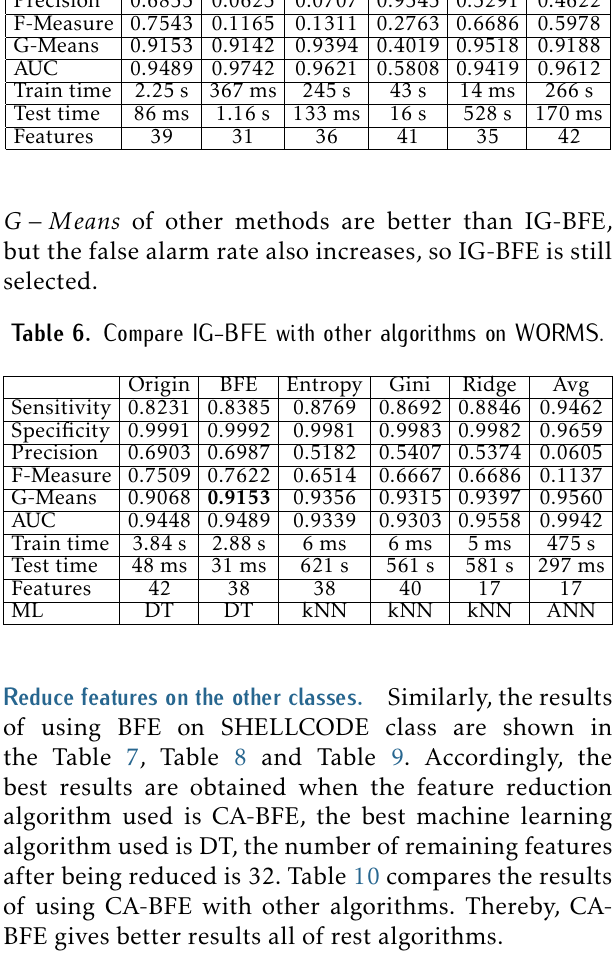
Table 7. Results of using IG-BFE algorithm on